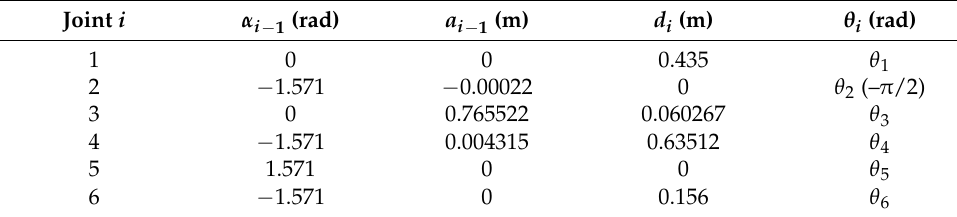
Figure 1. Specified robot structure. Table 1. Modified Denavit–Hartenberg parameters of the specified robot.